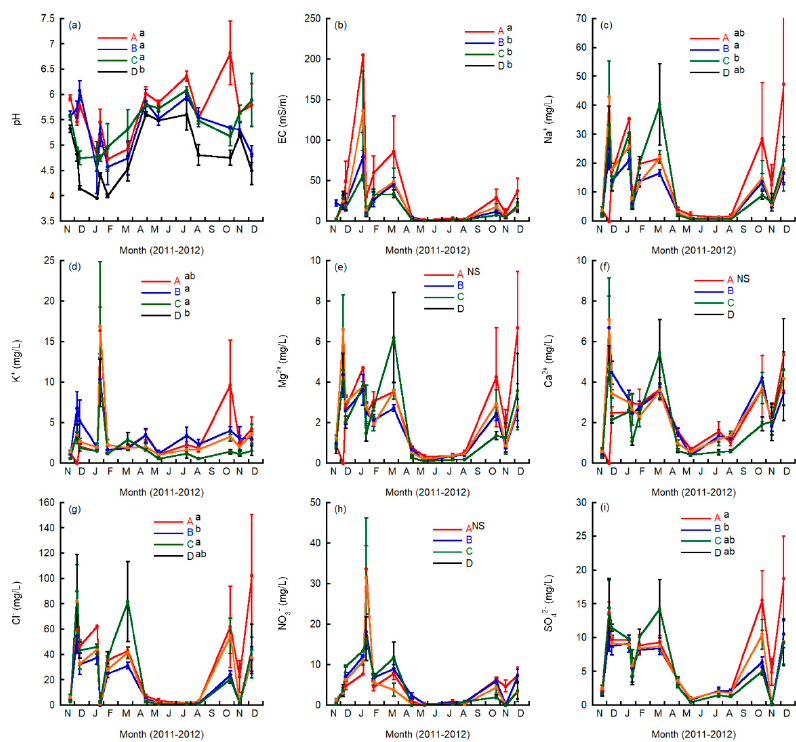
Figure 5. Throughfall chemistry in each quadrat collected with five sampling bottles located 10-m intervals under the canopy of trees with foliage over each quadrat of the Sanri-Matsubara Forest, south-western Japan. ( a ) pH, ( b ) EC, ( c ) Na + , ( d ) K + , ( e ) Mg 2+ , ( f ) Ca 2+ , ( g ) Cl ‒ , ( h ) NO 3 ‒ , and ( i ) SO 42 ‒ . Vertical bars denote SE. Significance of difference between quadrats was tested by Friedman test and the following Wilcoxson signed rank test with Bonferroni correction. Variables of quadrat names sharing the same letter were not significantly different ( p > 0.05). NS: not significant.